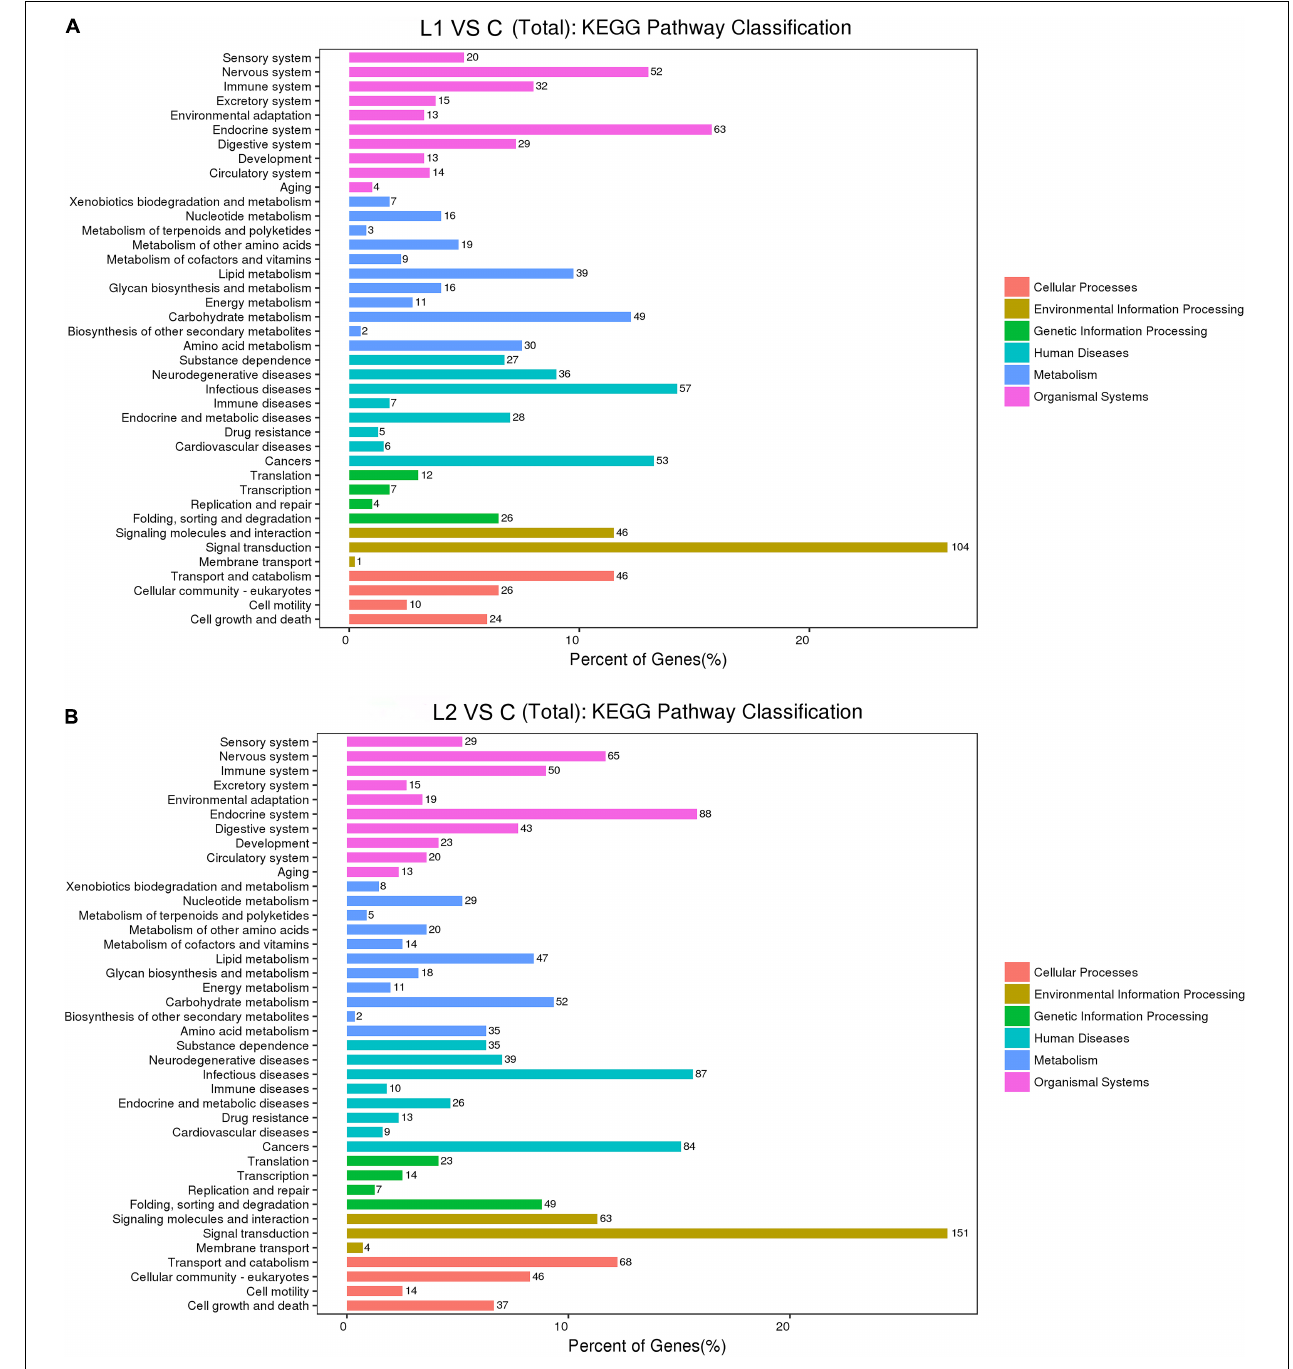
FIGURE 6 | Comparison of the distribution of differentially expressed genes and all genes in KEGG level 2 in L1 (A) and L2 (B) groups compared to the C group. The horizontal axis is the ratio (%) of the genes annotated to each level 2 pathway (differentially expressed genes) to the total number of all genes annotated to the KEGG pathway (differentially expressed genes), the vertical axis indicates the name of the level 2 pathway, and the number on the right of the bar represents the number of differentially expressed genes annotated to that level 2 pathway.